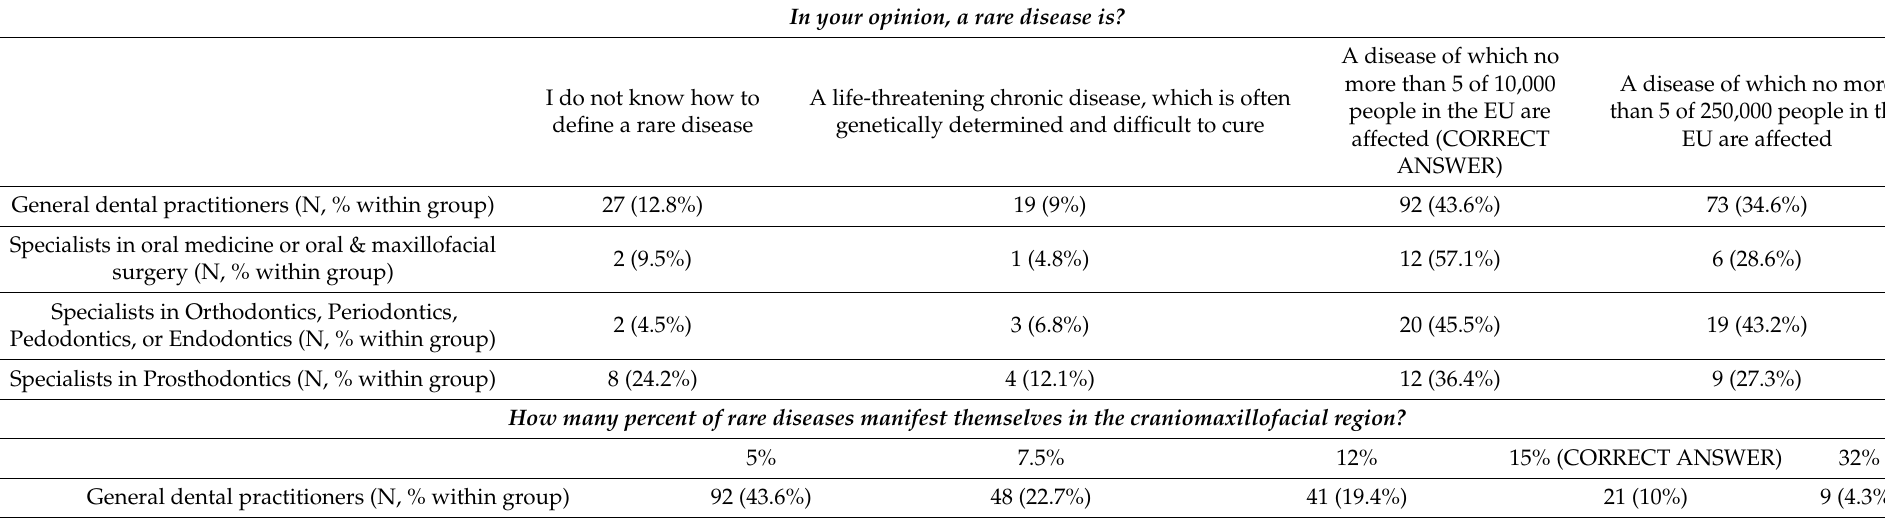
Table 3. Breakdown of participants answering questions regarding definitions, prevalence (3a,b) and diagnosis (3c) of rare diseases. In your opinion, a rare disease